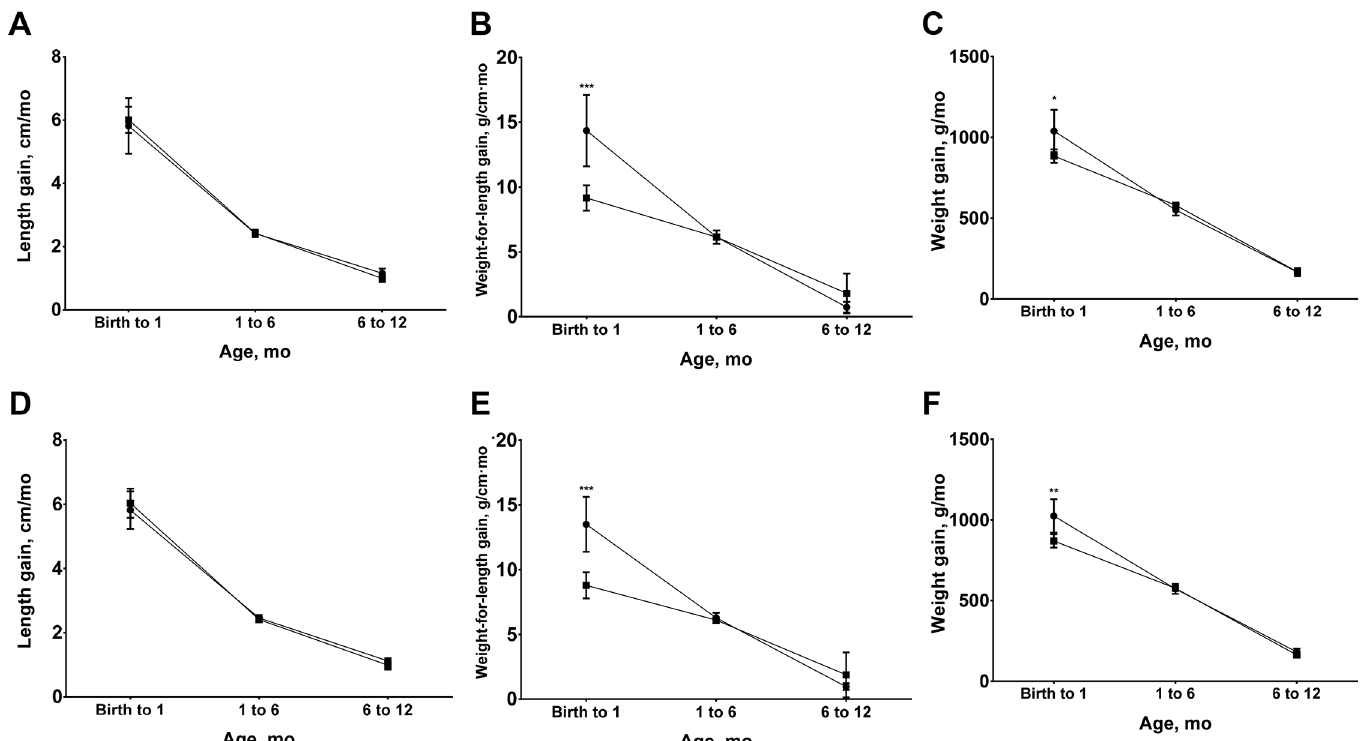
Fig 4. Length, weight-for-length and weight gains from birth to 12 months of age by birthweight (A, length gain; B, weight-for-length gain; C, weight gain) and size for gestational age (D, length gain; E, weight-for-length gain; F, weight gain). Values are means and 95% confidence intervals, n = 357. In A, B, and C, square symbols indicate low birthweight; circle symbols indicate non-low birthweight. In D, E, and F, square symbols indicate small- for-gestational age; circle symbols indicate non-small-for-gestational age. Low birthweight was defined as birthweight < 2.5kg. Small-for-gestational age was defined as birthweight < 10 th percentile for gestational age. * P < 0.05, ** P < 0.01, *** P < 0.001 different from non-LBW or non-SGA